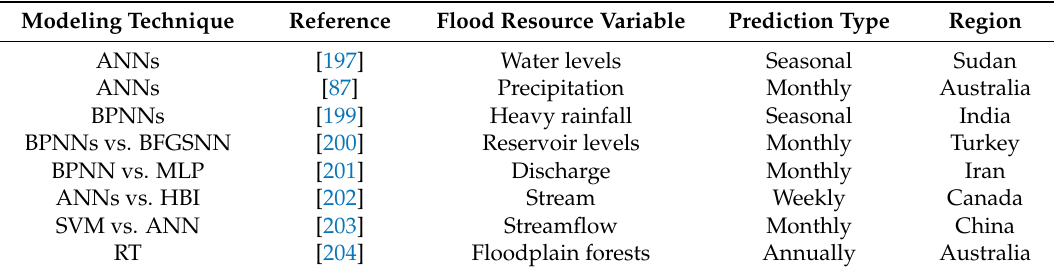
Table 4. Long-term flood prediction using single ML